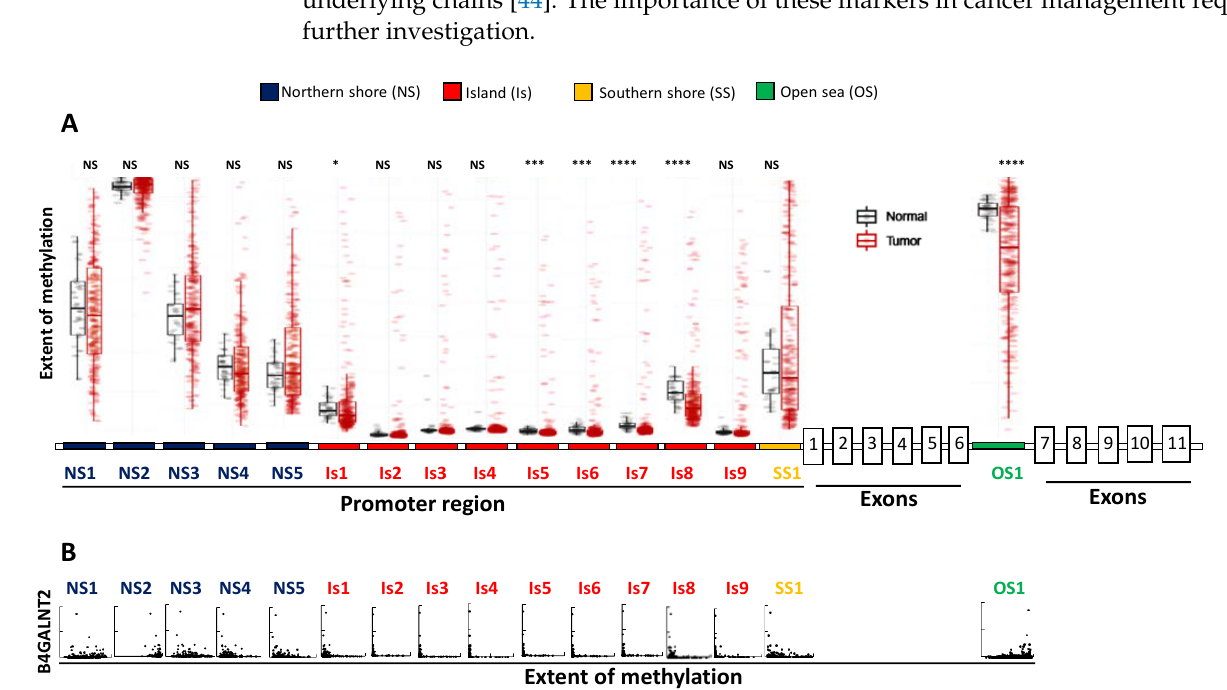
Figure 4. TCGA data on the methylation of the B4GALNT2 gene in normal and CRC tissues. ( A ): extent of methylation in normal and CRC tissues of CpG positions in the NS (blue, five positions), CpG island (Is, red, nine positions), SS (yellow, one position), and OS (green, one position). The promoter region and the coding exons have not been drawn to scale. ( B ): B4GALNT2 mRNA expression plotted vs. the extent of methylation in cancer tissues. * p < 0.05; *** p < 0.001; **** p < 0.0001.